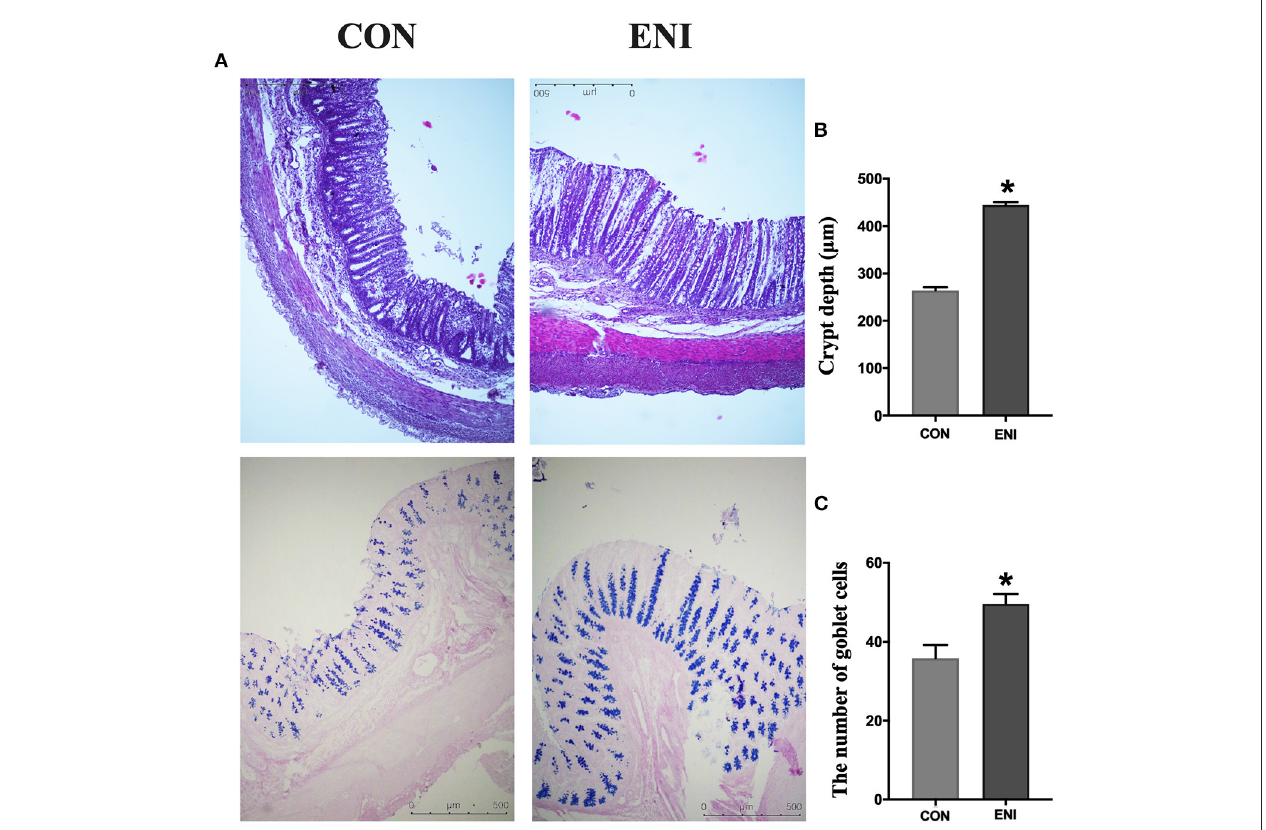
FIGURE 3 | Effects of early-life nutrition interventions on the morphology of the colon and the number of goblet cells. CON, control group, ENI, early-life nutrition interventions group. (A) . HE and PAS staining of colon tissue. (B) The crypt depth of the colon. (C) The number of goblet cells of the colon. Data are expressed as mean ± SEM ( n = 4). The independent-samples t-test was used to compare data between two groups. * P < 0.05.